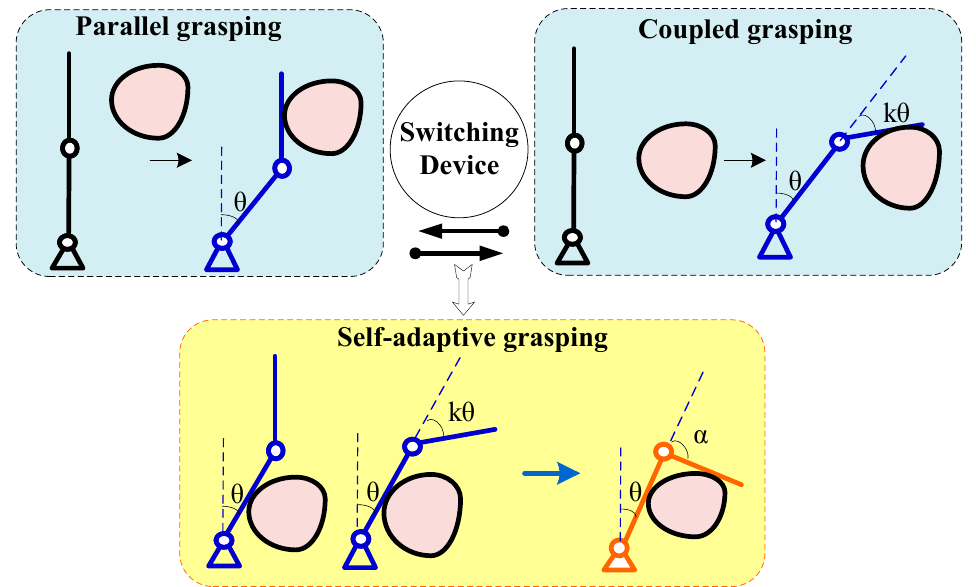
Figure 1. Integration method of parallel grasping mode, coupled grasping mode, and self-adaptive grasping mode.